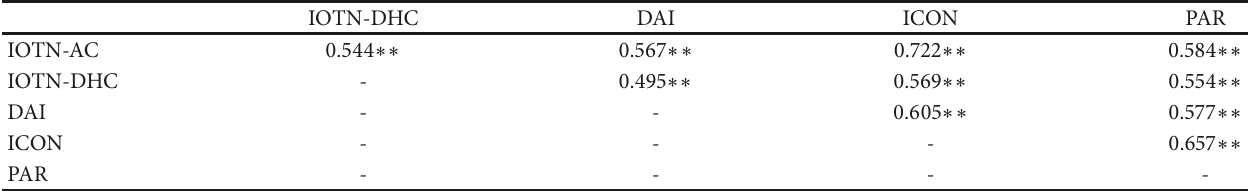
Table 2: Associations between the IOTN, DAI, ICON, and PAR.